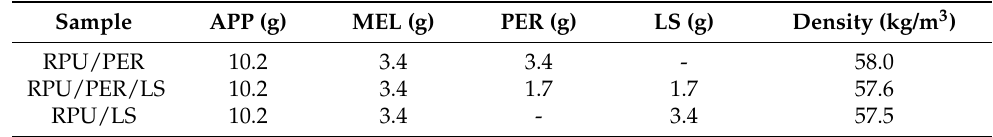
Table 1. The formulation of IFR for RPU foams.